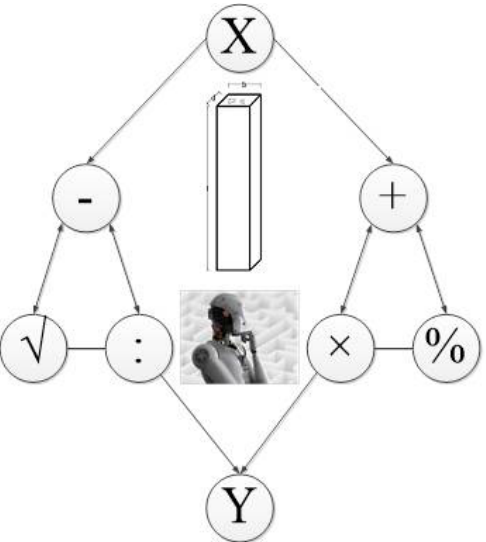
Figure 6. The schematic of using AI techniques for the SCFST columns.